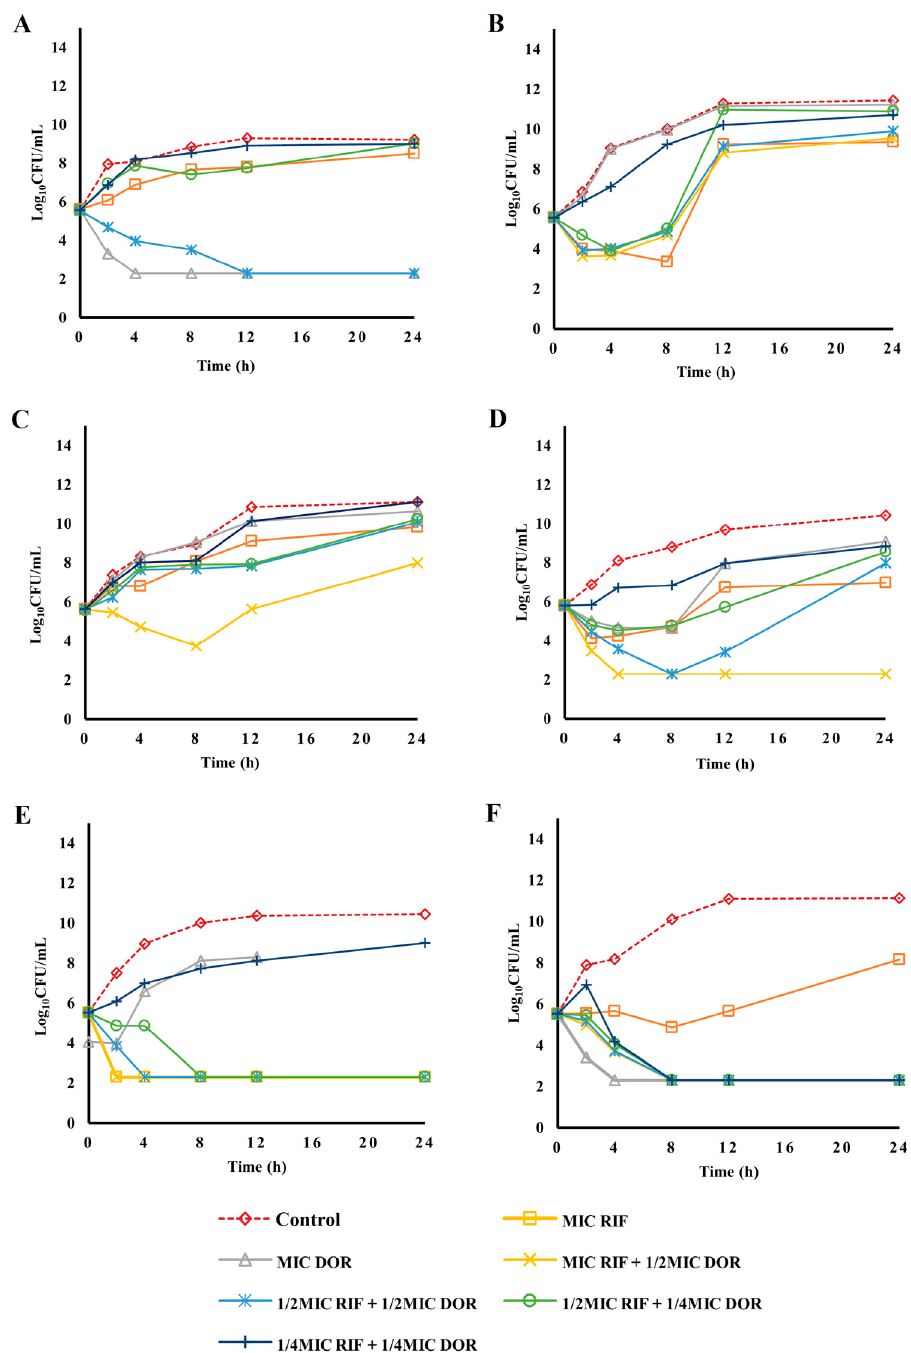
Figure 2. Time-kill kinetics of rifampicin and combination with doripenem against rifampicin-resistant and carbapenem-resistant clinical isolates of A. baumannii . SK015 ( A ), TR069 ( B ), and ST004 ( C ) are isolates with high rifampicin MIC ( ≥ 16 µg/mL), while TR131 ( D ), TR123 ( E ), and TR057 ( F ) are isolates with lower rifampicin MIC ( ≤ 8 µg/mL). Experiments were performed in duplicate. MIC, minimum inhibitory concentration; RIF, rifampicin; DOR, doripenem.